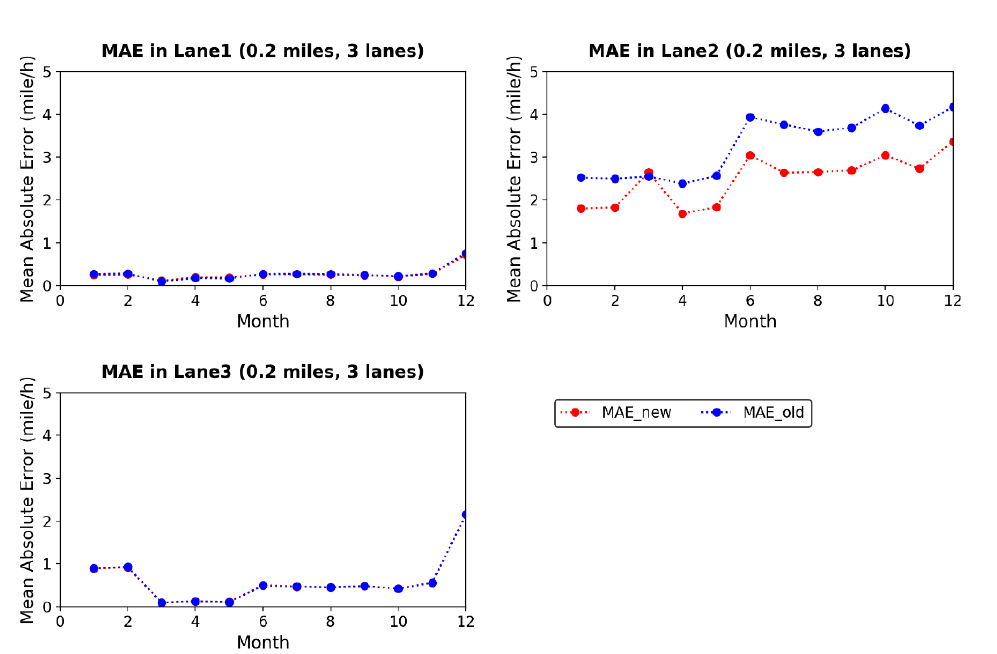
Figure 5. MAE curves of the new system and the old system in segment {0.2 miles, 3